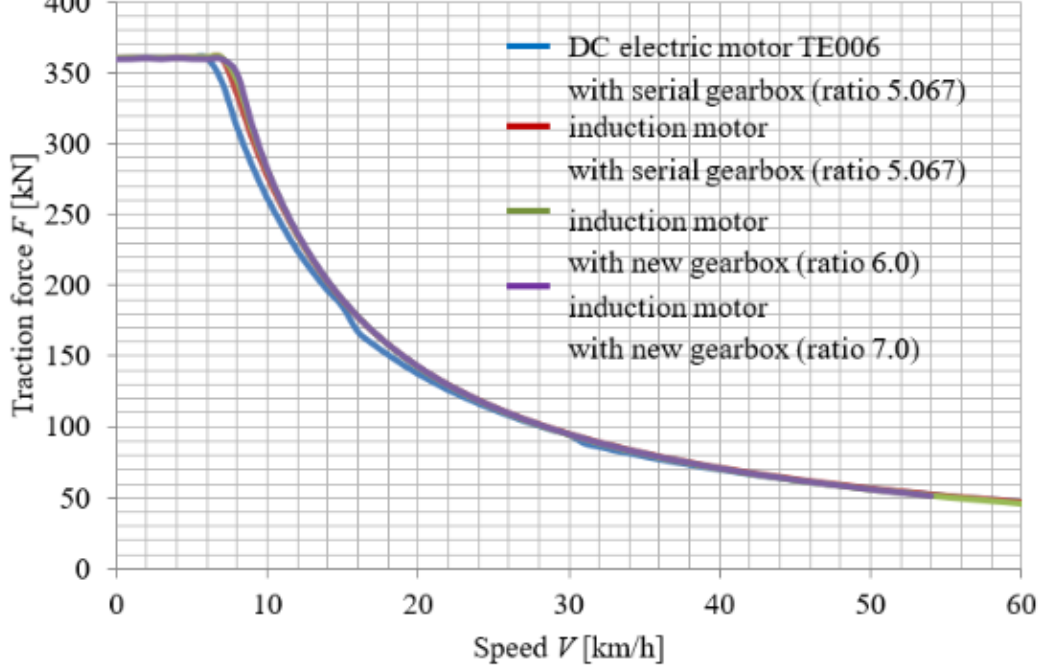
Figure 10. Traction characteristics of the ChME3 locomotive at 8 DCP. Source: own